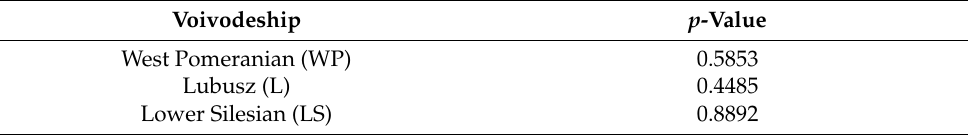
Table 4. P -value obtained after Shapiro-Wilk test.